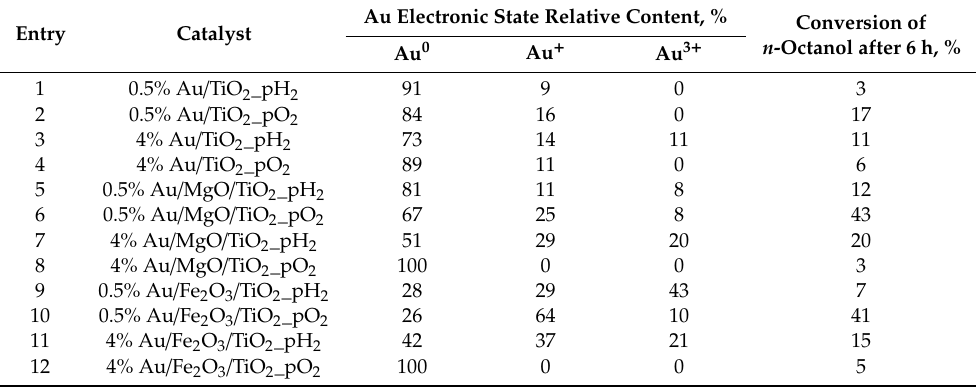
Table 3. Effect of gold content (0.5 or 4 wt.%) and redox treatment (H 2 or O 2 ) on the different electronic states of Au (determined by XPS), and their catalytic activity for n -octanol oxidation for Au/TiO 2 , Au/Fe 2 O 3 /TiO 2 , Au/MgO/TiO 2 catalysts. Entries 1–4 data are taken from [31,32].